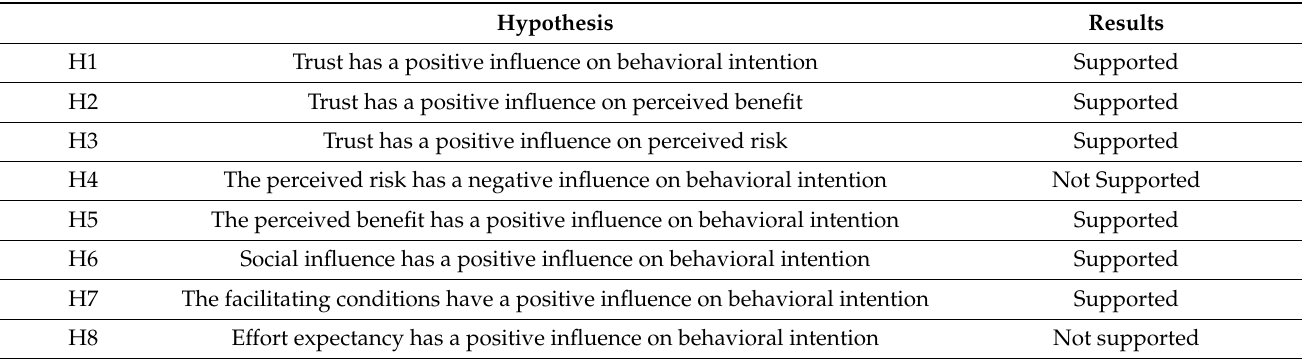
Table 10. Summary of hypotheses